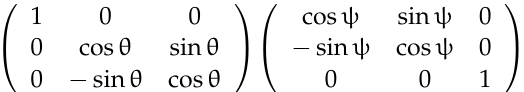
Figure 4. Orientation dependences of Young’s modulus for the (0001) ( a ) and